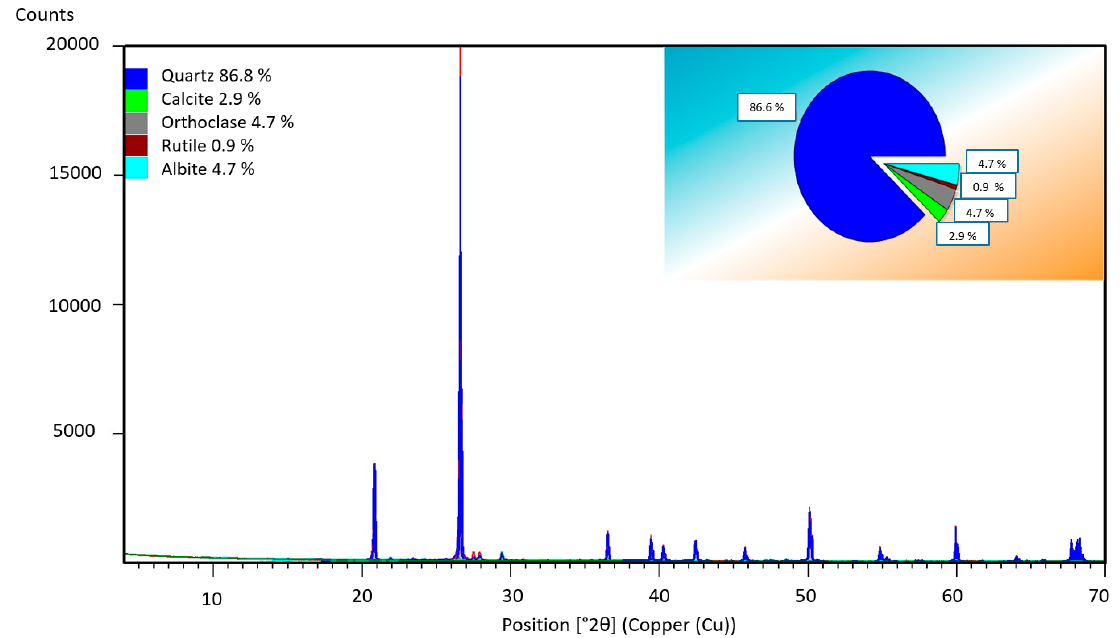
Figure 4. X-ray powder diffraction chart showing the mineral composition of the studied sand dune.